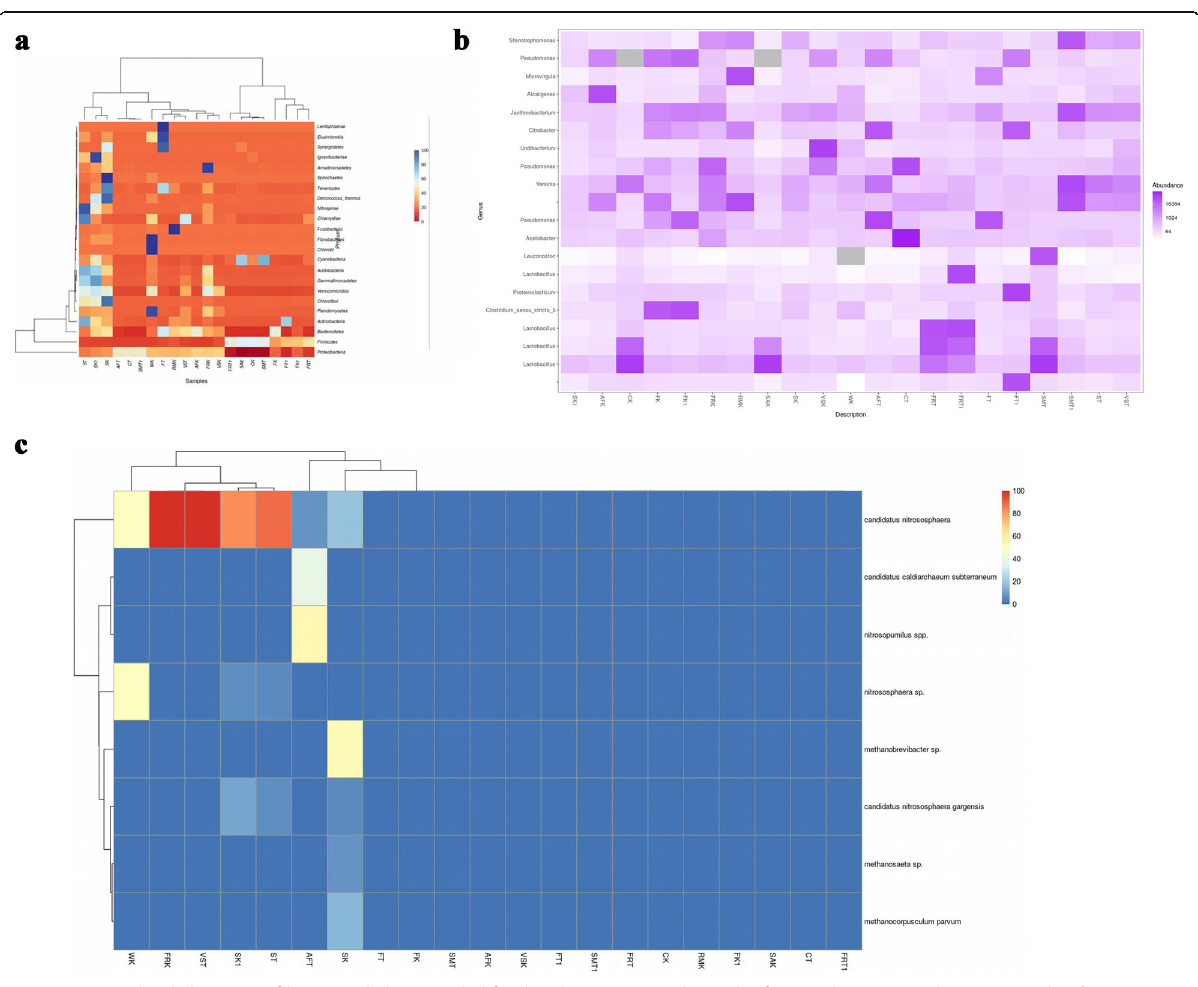
Fig. 5 a Hierarchical clustering of bacteria phyla in vended food and environmental samples from Embu Town and Kangaru Market. b Hierarchical clustering of bacteria genera in vended food and environmental samples from Embu Town and Kangaru Market. c Hierarchical clustering of archaea in vended food and environmental samples from Embu Town and Kangaru Market. Key: African Sausage Kangaru